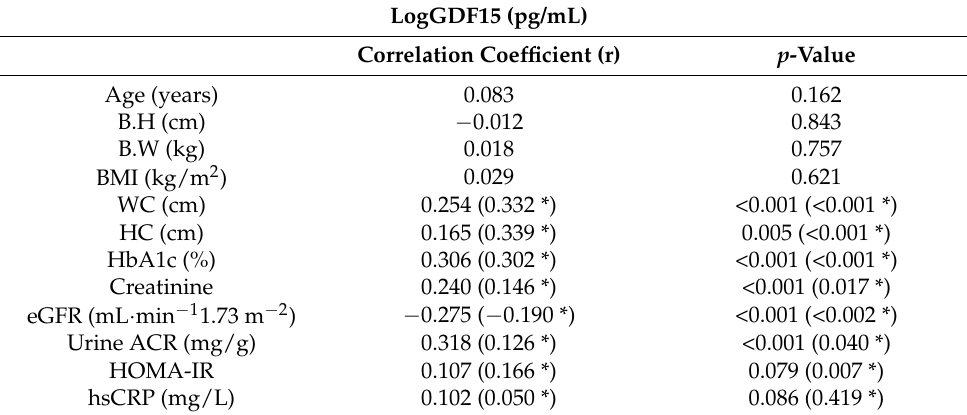
Table 6. Correlation between GDF15 and clinical